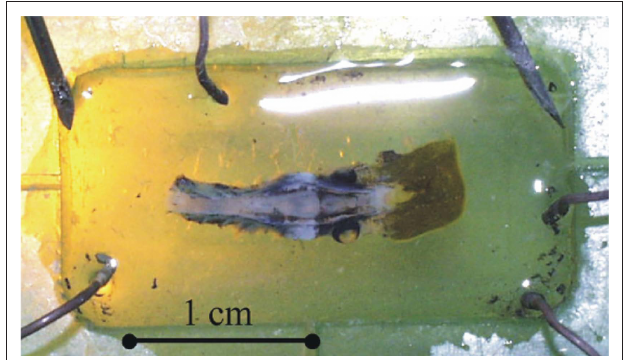
FIGURE 2 | The lamprey. The neural element of the BMI system is the dissected brain of Sea Lamprey maintained alive within the recording